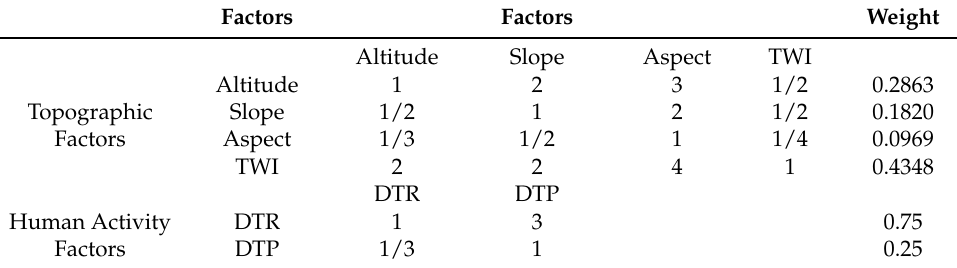
Table 10. The comparison matrix of each factor in a type.